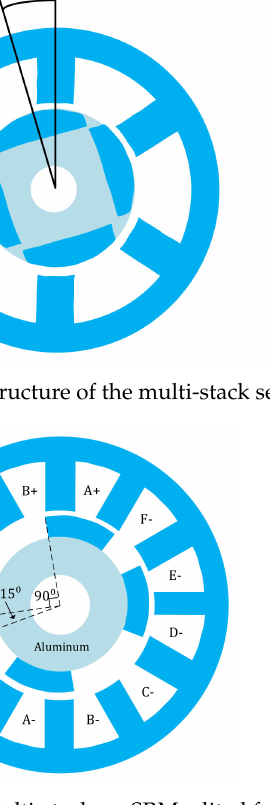
Figure 8. Multi-stack segSRM edited from [61]. Table 2. One-stack and multi-stack segmental